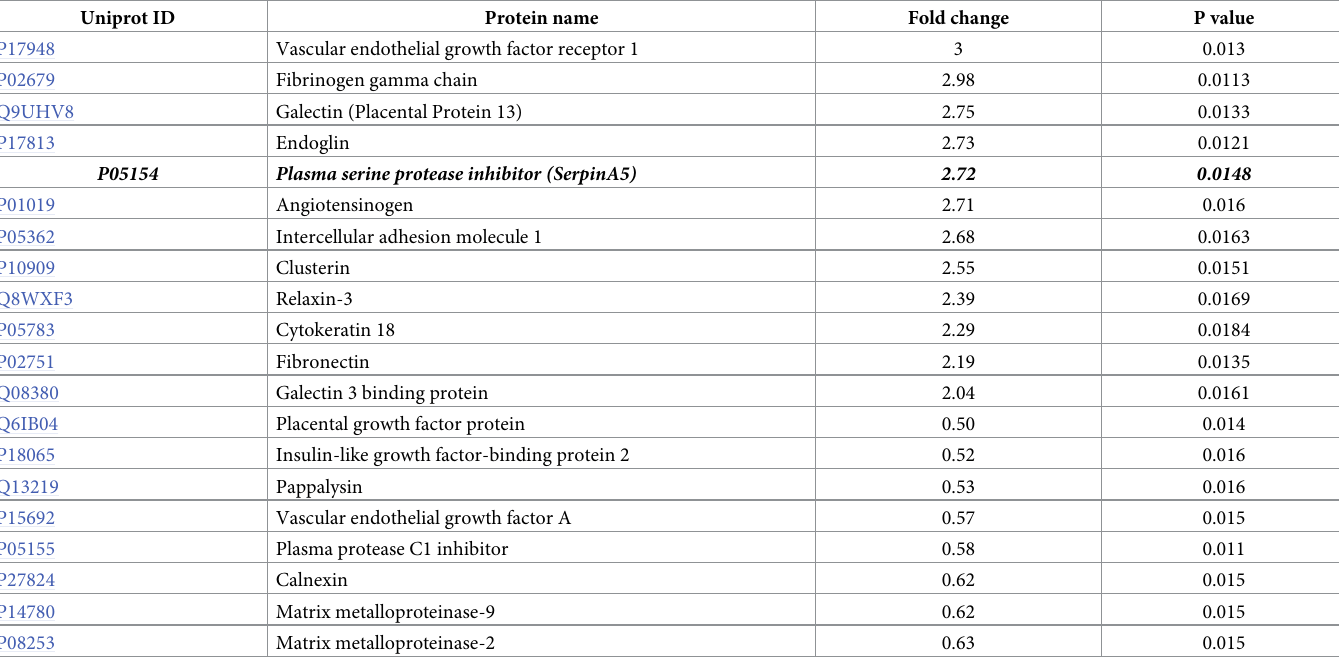
Table 2. Twenty proteins were significantly different in plasma exosomes between the PE and control groups (12 upregulated; 8 downregulated). Uniprot ID